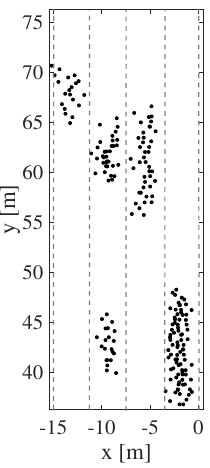
Figure 14. Sampling points of Scene